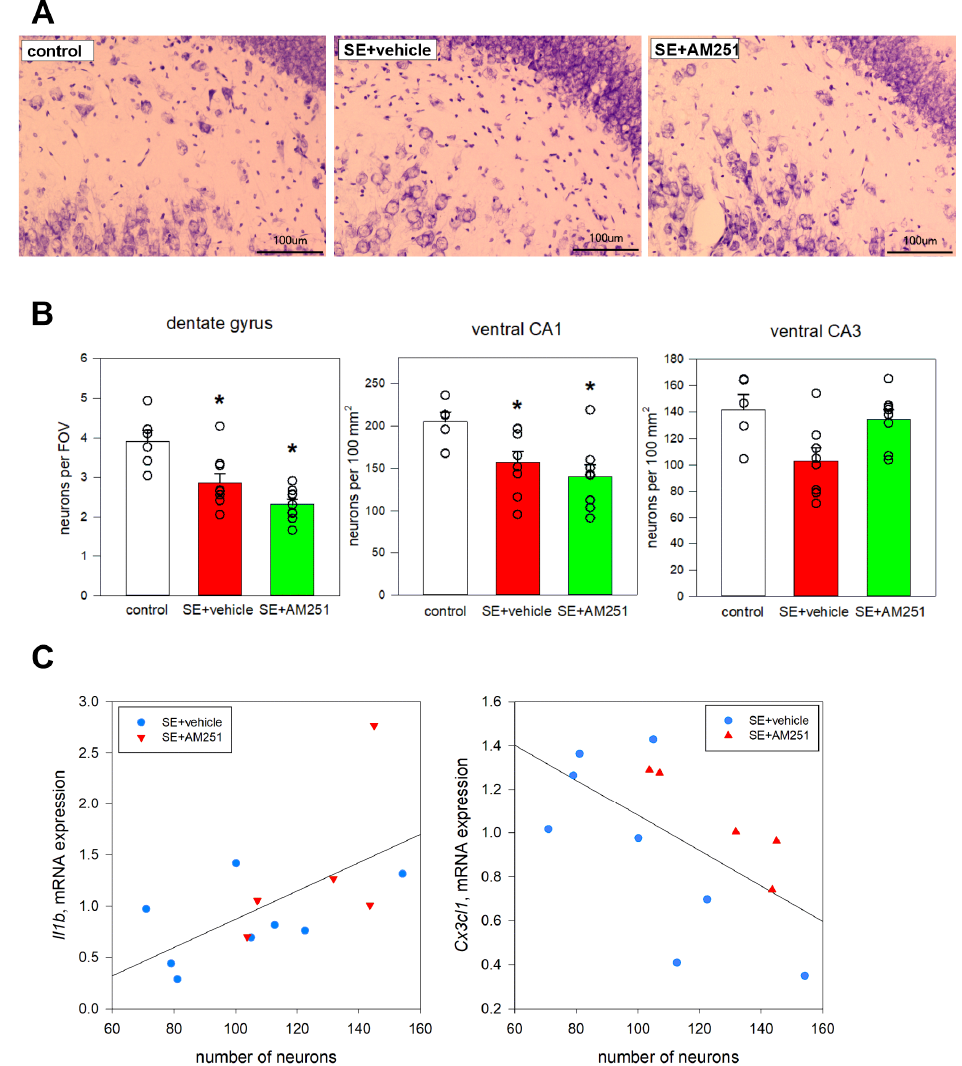
Figure 7. ( A ) neurodegeneration in the dentate gyrus of vehicle-treated and AM251-treated rats 5 months after SE. The control rats without SE had visibly more neurons, especially in the hilus of the dentate gyrus; ( B ) the neuronal count in the hippocampus of rats with no SE (control), vehicle- treated treated rats (SE + vehicle), and AM251-treated rats (SE + AM251) 24 h and 7 days after SE. Data are presented as mean ± SEM; dots represent individual values for each rat. *—signi fi cant differences at p < 0.05, ANOVA; ( C ) correlations between the number of neurons in the ventral hippocampus (X-axis) and the expression of Il1b (Spearman correlation 0.59, p < 0.05) and Cx3cl1 (Spearman correlation − 0.61, p < 0.05) (Y-axis) 5 months after SE.